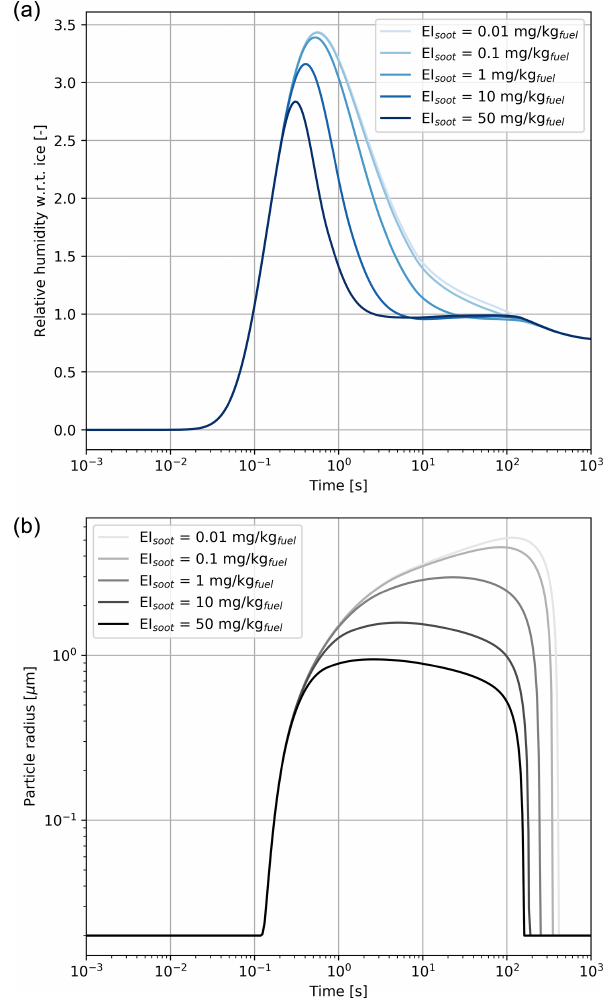
Figure 6. Relative humidity with respect to ice (a) and particle ra- dius (b) for a black carbon mass emission index varying from 0.01 to 50mgkg − 1 fuel